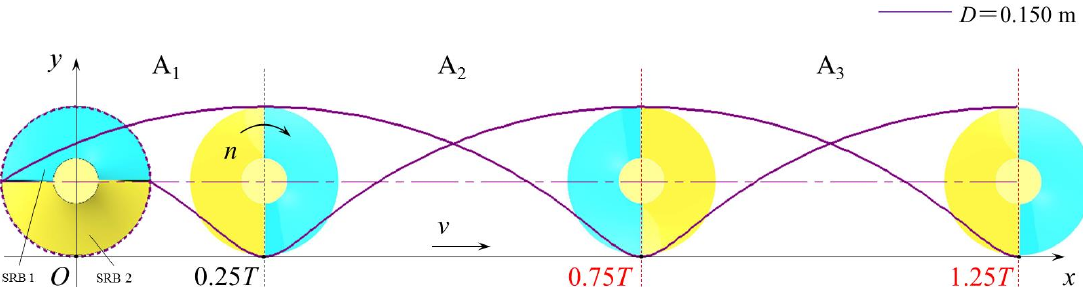
Figure 6. The trajectory of the tip of the SRB when D = 150 mm. Note: D is the ODRD, mm; n is the RVSS, rpm; v is the operating velocity of machines, km/h. In order to describe the motion law of the